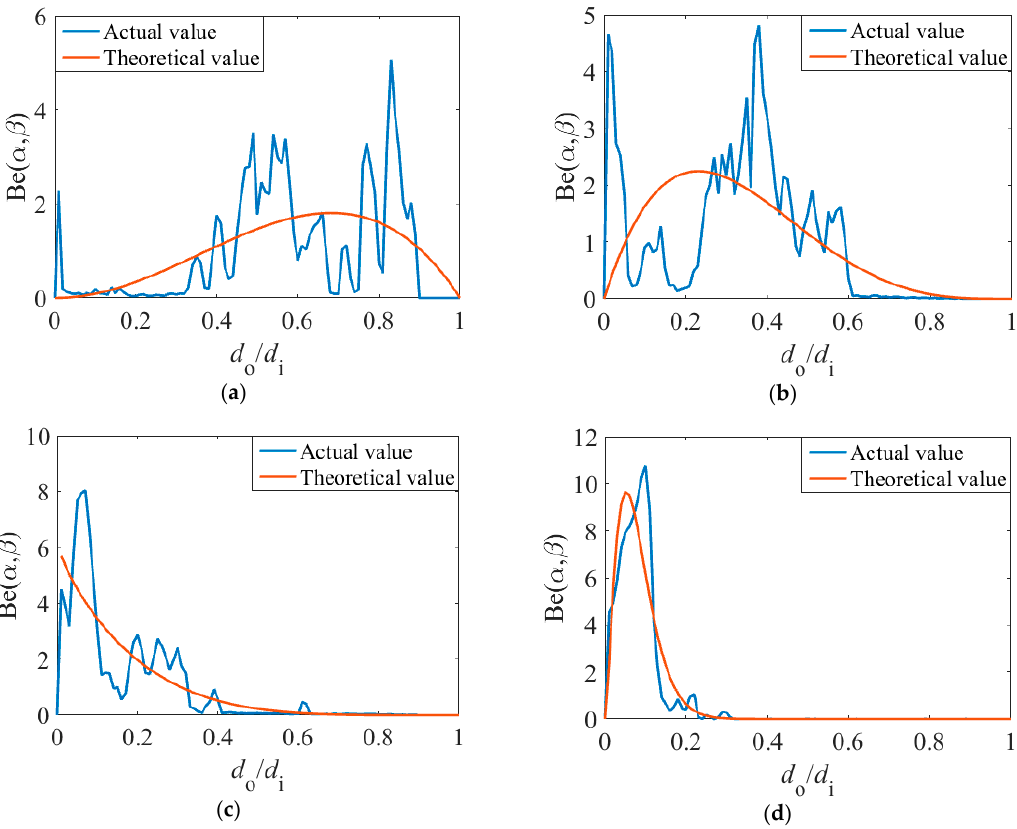
Energies 2019 , 12 , x